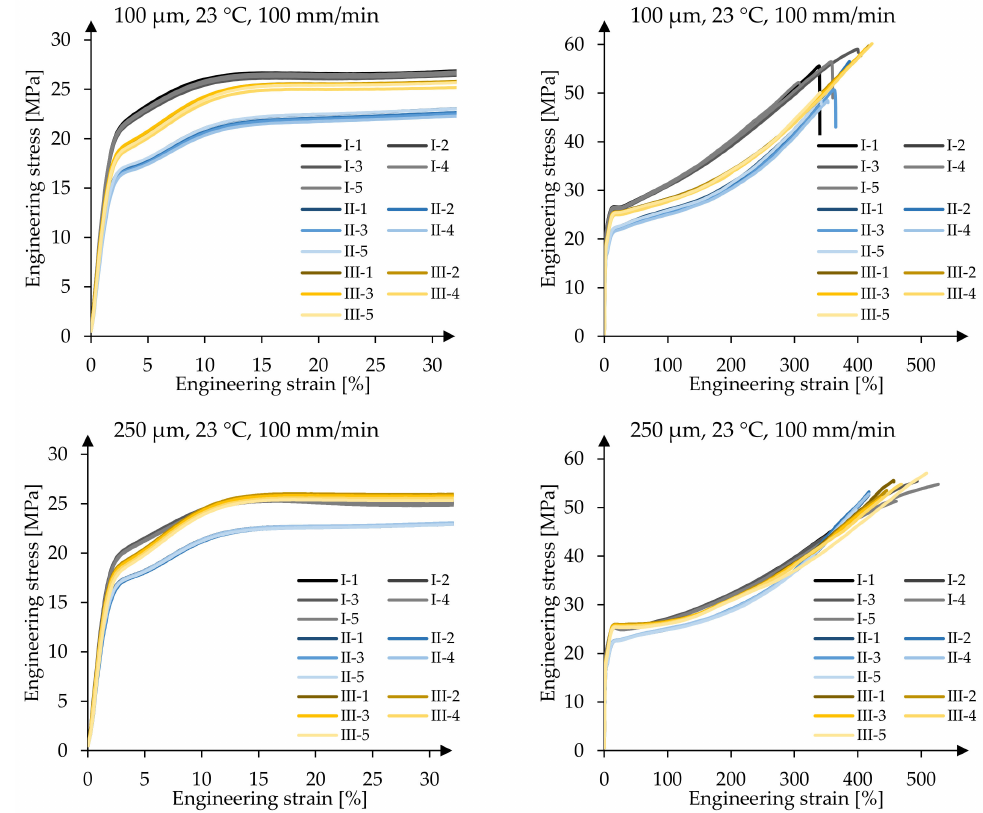
Figure 3. Comparison of uniaxial tensile tests in MD at 23 ◦ C and 200%/min for producers I, II, and III ( left side diagrams are cut-outs from the right side